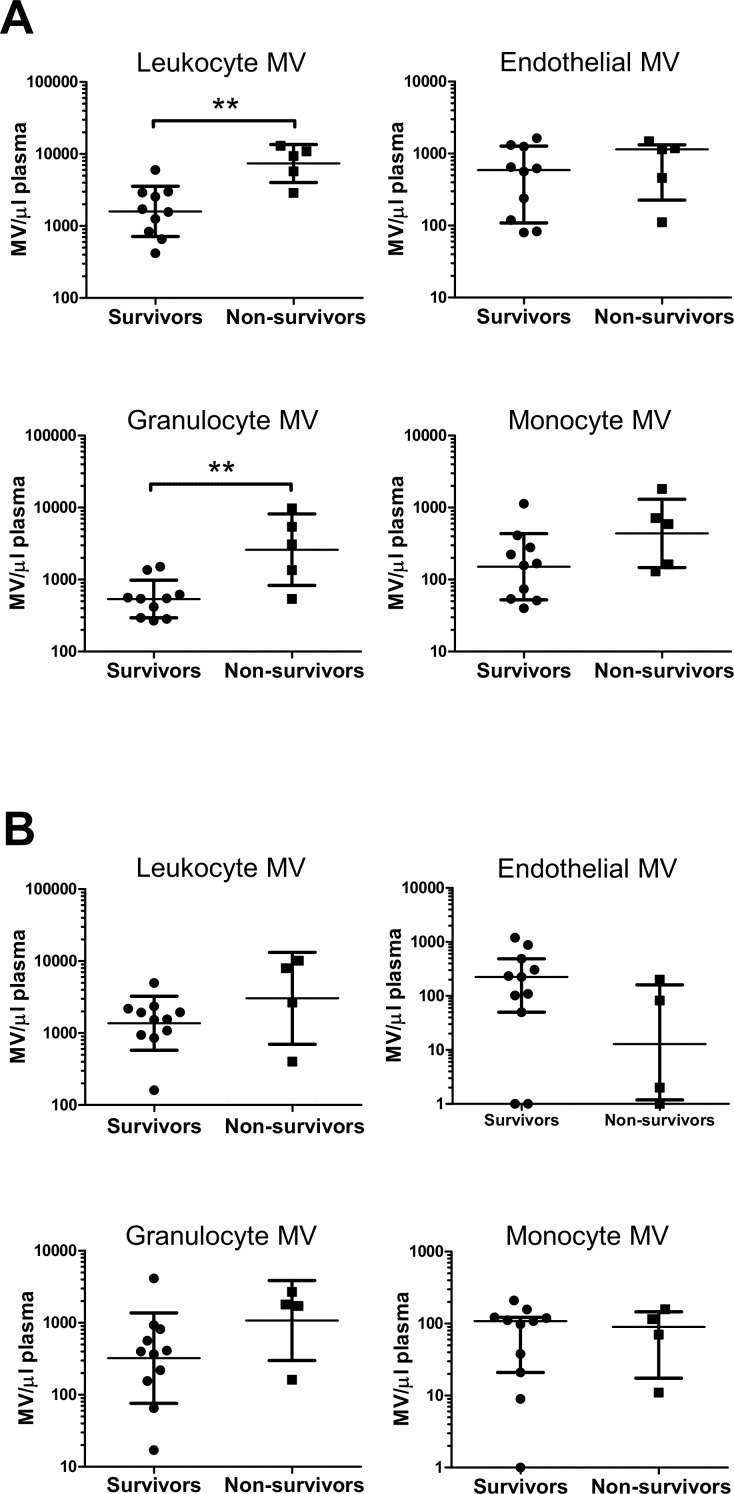
Comparison of circulating MV levels in burns and sepsis patient survivors and non-survivors.Levels of MV subtypes were compared between burns patients that recovered (survivors, n = 10) or died in burns ICU (non-survivors, n = 5) (A) and sepsis patients that recovered (n = 11) or died (n = 4) in the general ICU (B). Data are log-transformed and analyzed by t tests (for burns: leukocyte-, granulocyte- and monocyte-derived MVs; sepsis: leukocyte- and granulocyte-derived MVs; mean ± SD) or Mann-Whitney U tests (for the remainder; median ± interquartile range). Levels of total leukocyte- and granulocyte-derived MVs were higher in burns non-survivors than survivors, **p < 0.01.